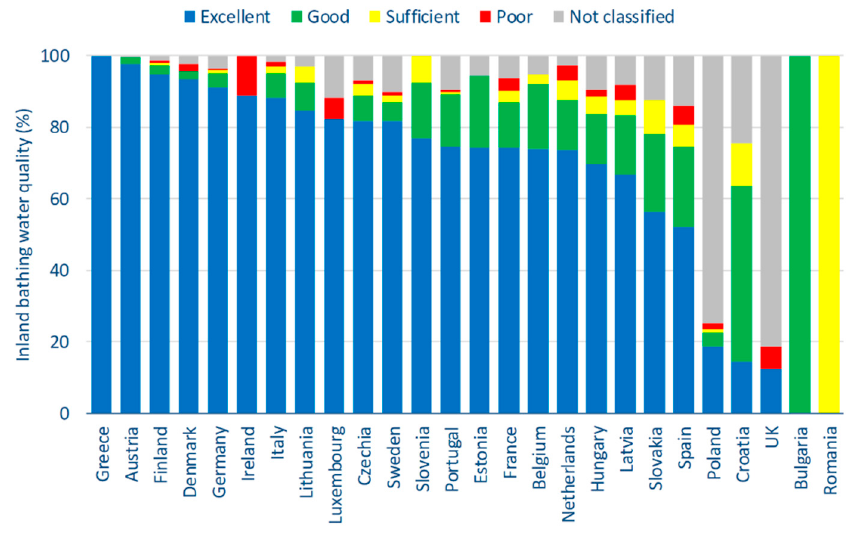
Figure 5. The quality of inland bathing waters in EU Member States in 2020.